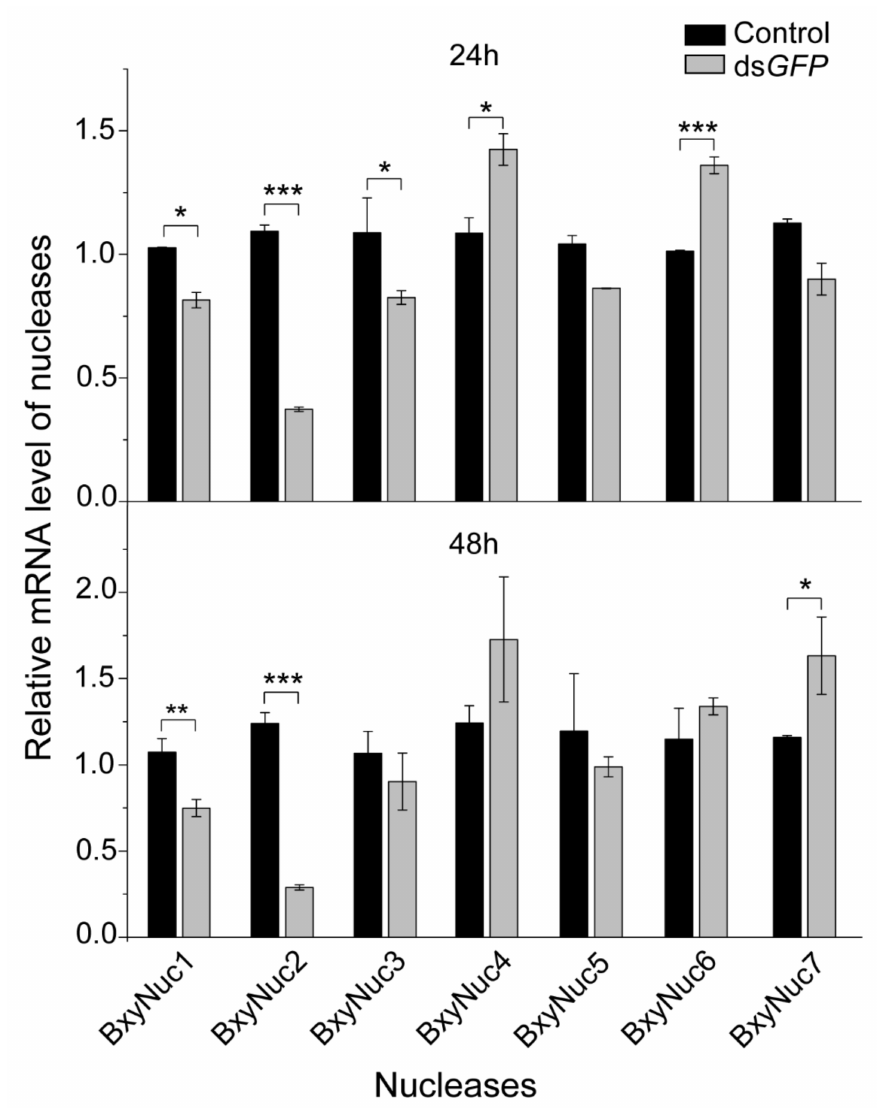
Figure 5. The relative expression level of nuclease genes in nematodes after soaking with ds GFP for 24 and 48 h. Gene expression differences between two groups were calculated using the independent samples t test. Data are presented as mean ± SE, *** p < 0.001; ** p < 0.01; * p <